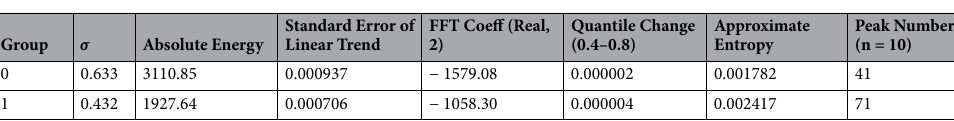
Table 3. Pupil-size statistics for significant